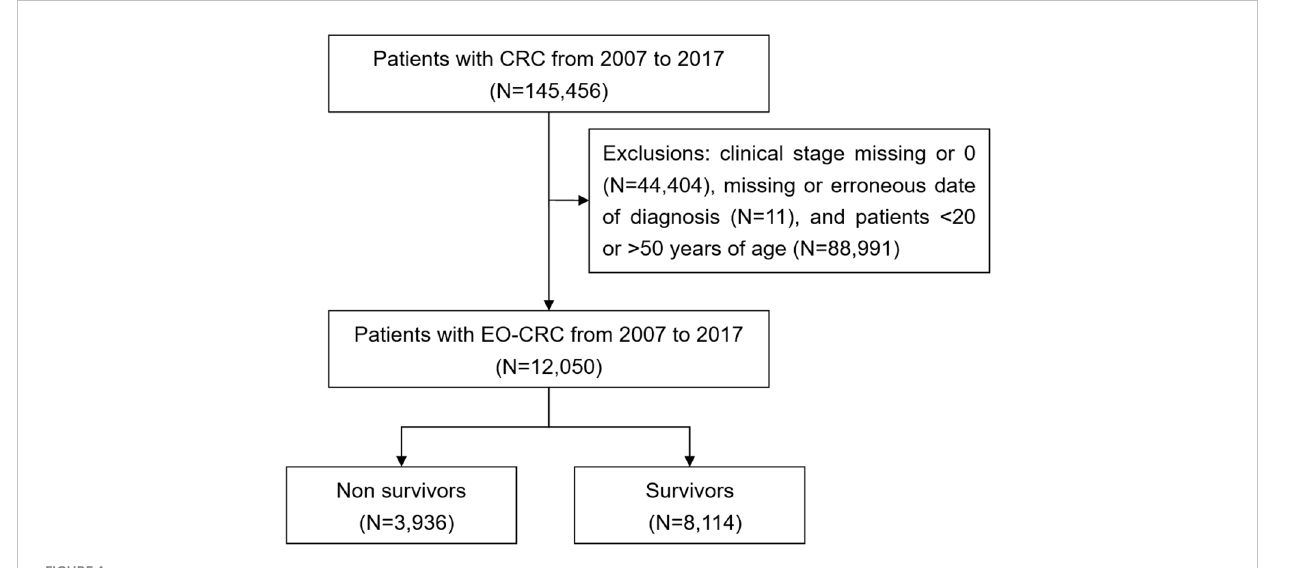
FIGURE 1 Patient selection fl